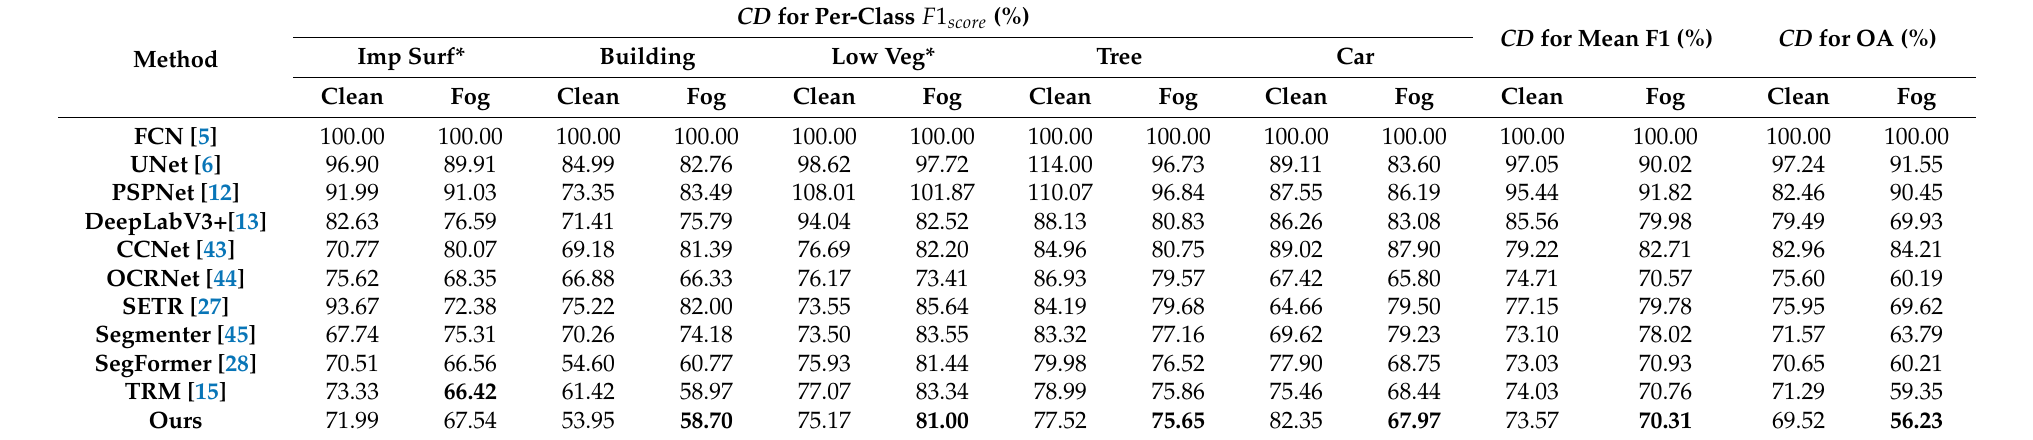
Table 9. Quantitative evaluation of CD on clean and fog corrupted variants of Potsdam test set about different SOTA methods. FCN is regarded as the reference and values lower than 100% represent an improvement in the robust performance compared with the reference. The minimum in each Fog column is